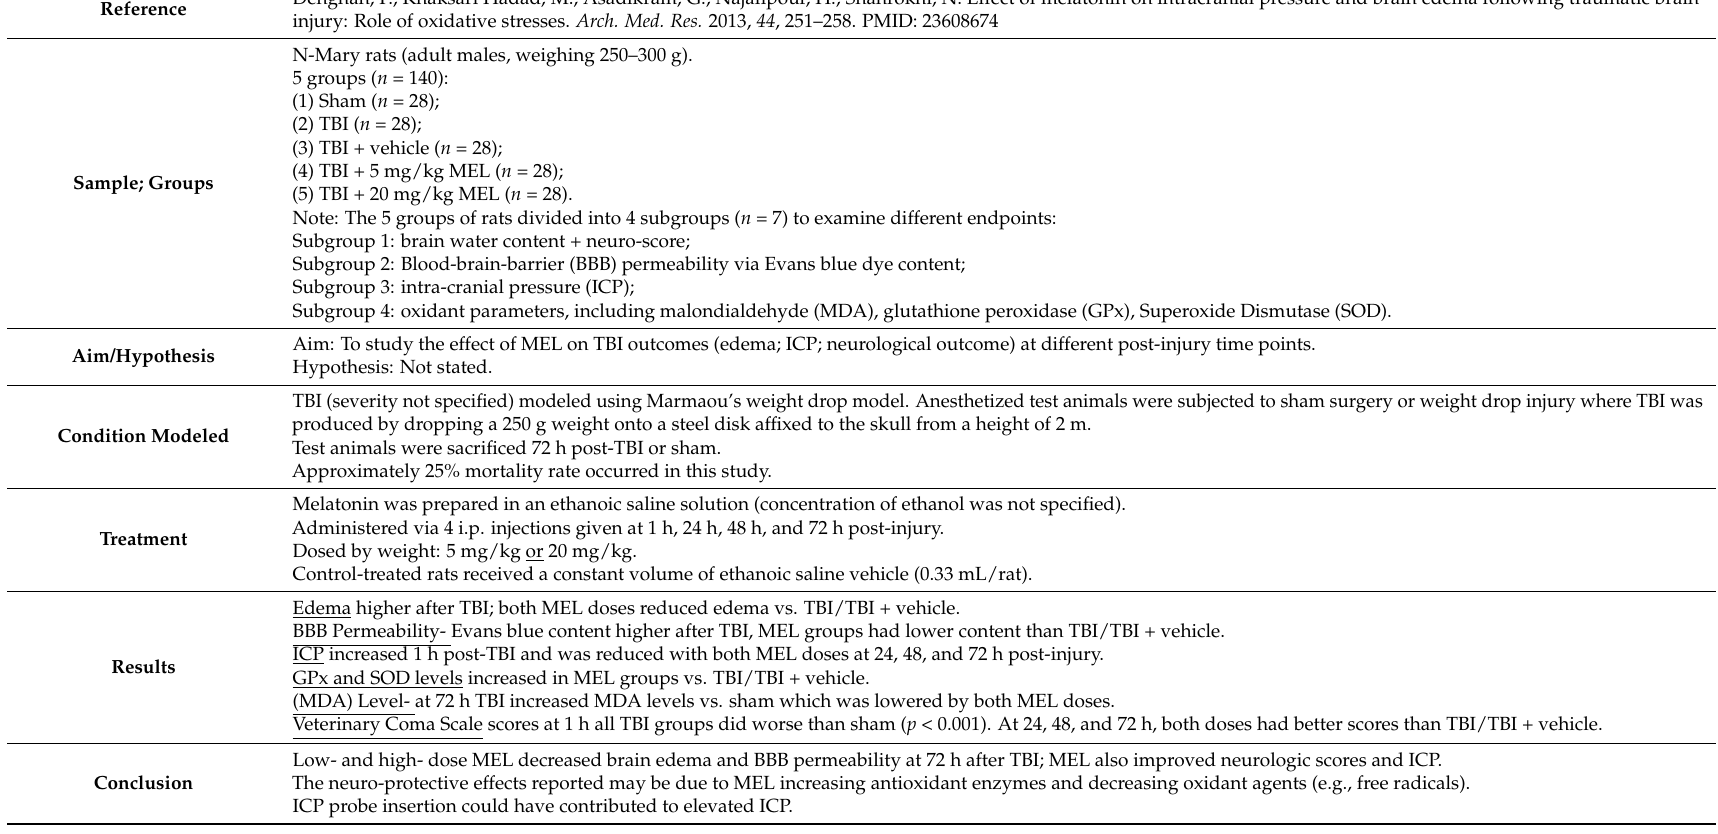
Table A12. Dehghan et al. (2013) Study